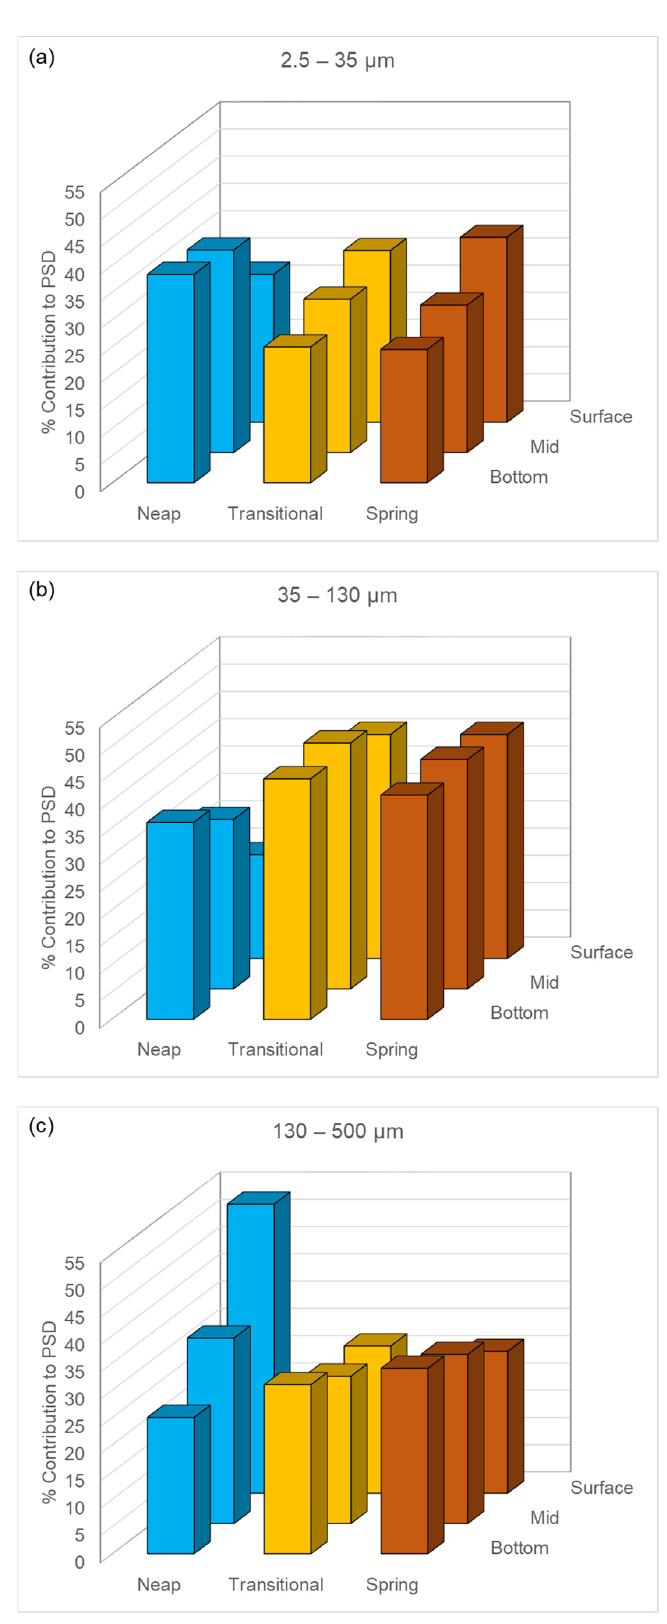
Figure 3. Site combined size classes ( a ) 2.5–35 µm, ( b ) 35–130 µm and ( c ) 130–500 µm contributions to the overall PSD for surface-, mid-, and bottom-water compartments during neap (blue bars), transitional (orange bars), and spring (brown bars) tide conditions.